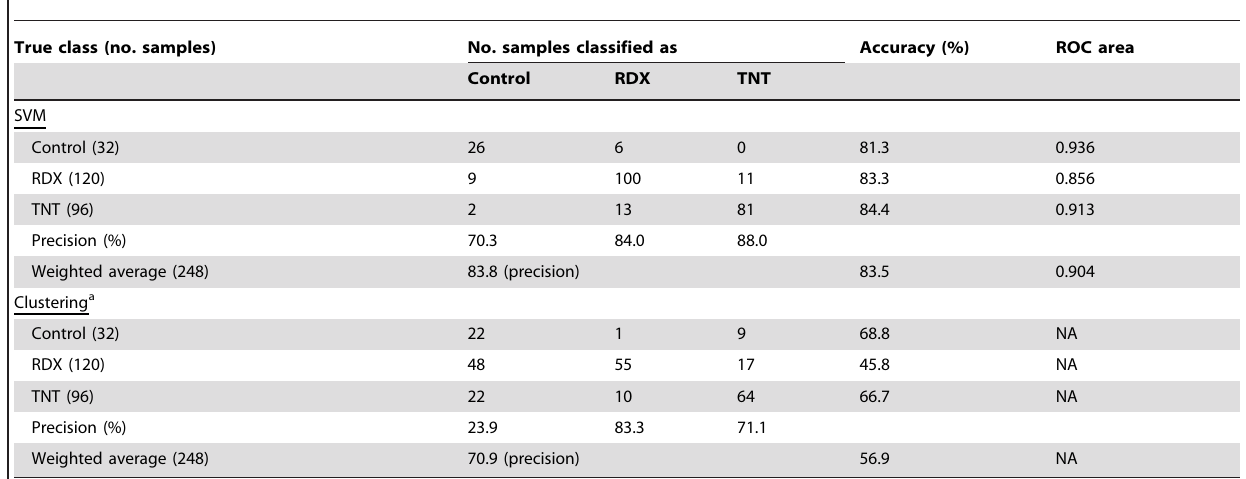
Table 4. Confusion matrix of classification results obtained using the refined set of 58 classifier genes combined from the SVM- and the clustering-optimized gene